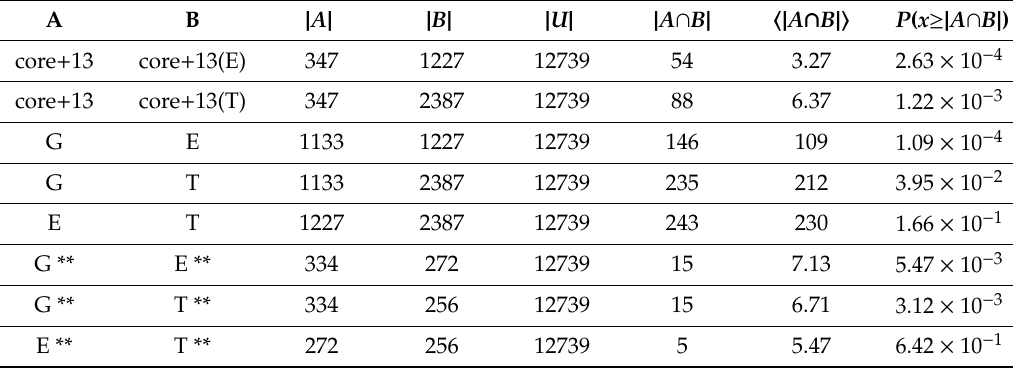
Table 3. Overlaps among the lists of genes associated with ASDs. G: Genomic; E: Epigenomics; T: Transcriptomics; ** major; * minor; core + 13(E) and core + 13(T) indicate genes belonging to the core + 13 set and which are supported by E and T,